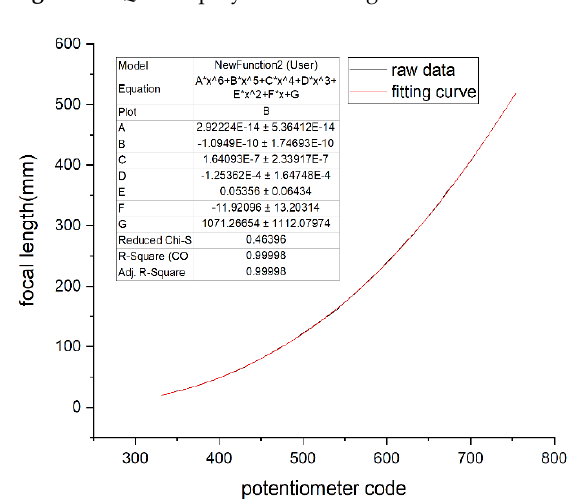
Figure 17. Quintic polynomial fitting.